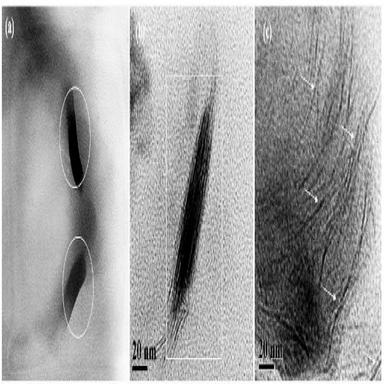
TEM micrograph of phase separated nanoclay (a), exfoliated (b), and intercalated (c) nanoclay in polymer matrix.